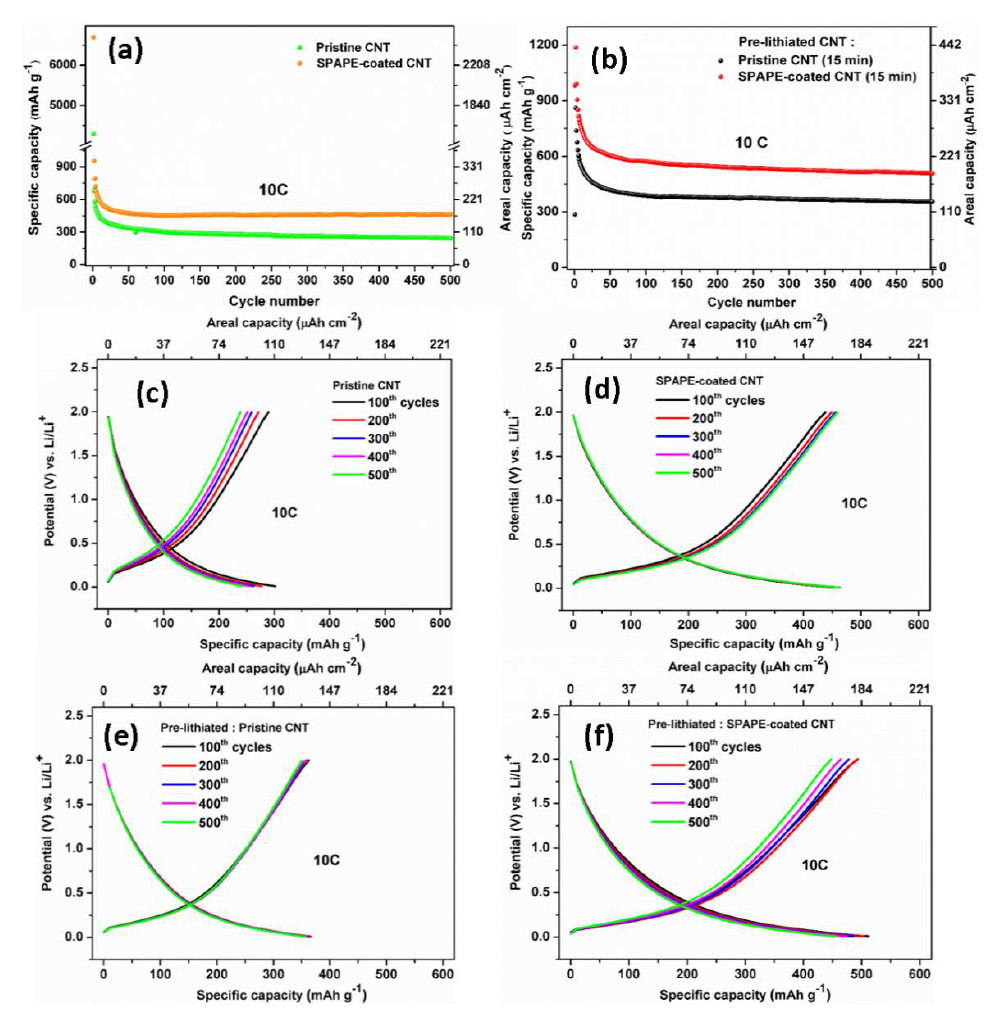
Figure 6. Long-term cycling performance of the ( a ) pristine and ( b ) pre-lithiated CNT anodes; galvanostatic charge–discharge curves of the ( c ) pristine CNT, ( d ) SPAPE-coated CNT, ( e ) pre-lithiated pristine CNT and ( f ) pre-lithiated SPAPE-coated CNT in the potential window of 0.01–2 V at a constant current density of 1.2 mA cm −2 .